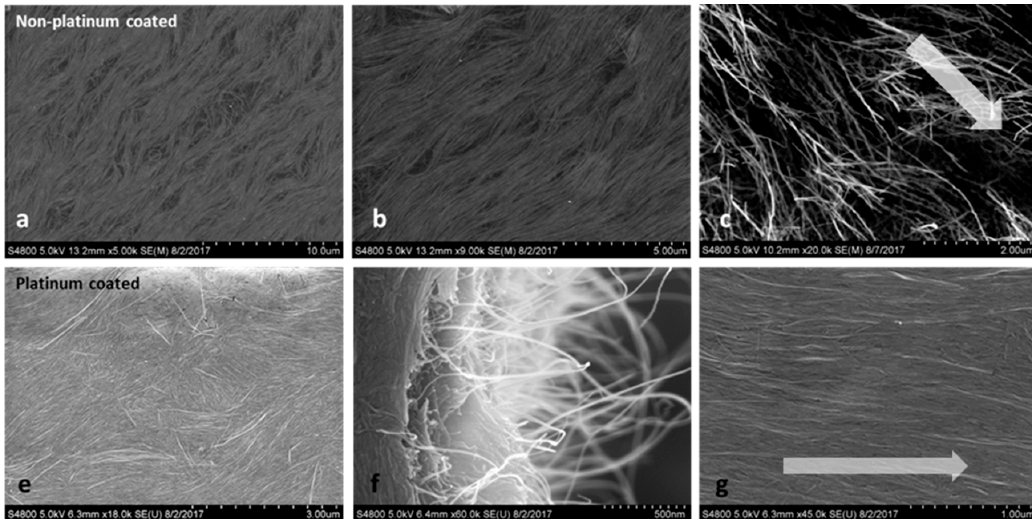
Figure 8. SEM images of 2% SWNT and 98% CNC hybrid films. ( a , b ) Images of sedated dried hybrid films without platinum coating. ( e , f ) Images of sedated dried hybrid film with platinum coated. ( c , g ) Images of a blade-coated film ( c ) without platinum coating and ( g ) with platinum coating. The arrow represents the blade shear direction.